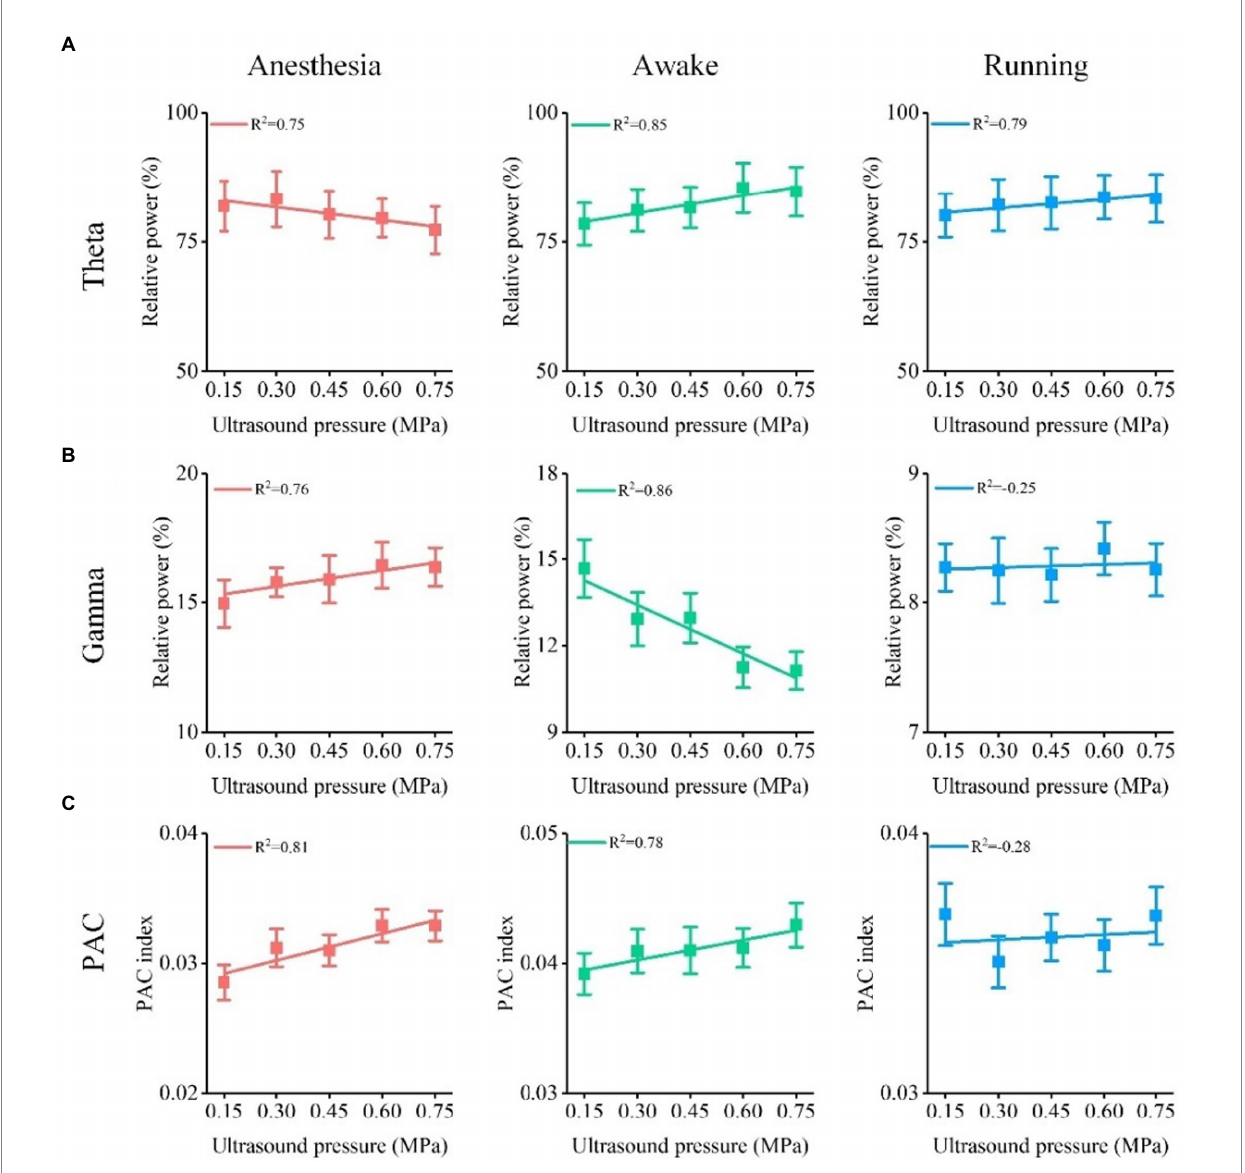
FIGURE 6 Relationship between relative power, PAC of theta and gamma oscillation, and ultrasound intensity under different behavioral states. (A) Relative power of theta oscillation vs. ultrasound intensity. (B) Relative power of gamma oscillation vs. ultrasound intensity. (C) Δ PAC/PAC between theta and gamma oscillation vs. ultrasound